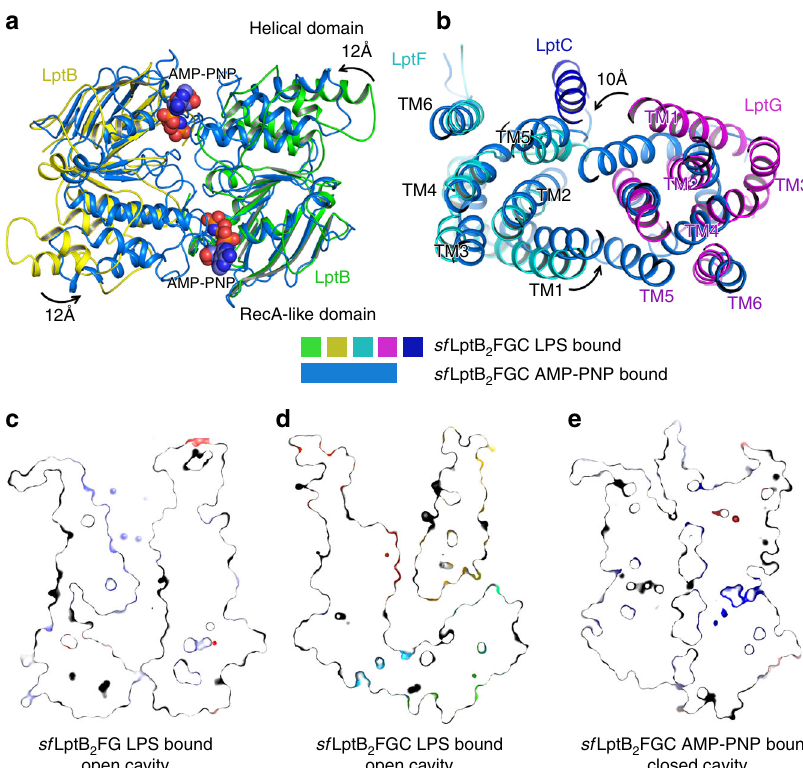
Fig. 5 Superimpositions of AMP-PNP and LPS-bound sf LptB 2 FGC structures. a AMP-PNP binding induces the conformational changes of LptB (NDBs). The helical domains of the dimeric LptB (AMP-PNP-bound sf LptB 2 FGC) showed a rotational shift of ~12 A ̊ in the anti-clockwise direction from the nucleotide- free state of dimeric LptB (LPS-bound sf LptB 2 FGC). The LPS-bound sf LptB 2 FGC is coloured in the same as Fig. 1. The AMP-PNP-bound sf LptB 2 FGC is coloured in marine blue and AMP-PNP shows as spheres. b A top view of superimposed transmembrane helices of LPS-bound sf LptB 2 FGC and AMP-PNP- bound sf LptB 2 FGC complex. AMP-PNP binding induces the TM helices of AMP-PNP-bound sf LptB 2 FGC to rotate in the anti-clockwise direction with the largest shift of ~10 A ̊ from the nucleotide-free state (LPS-bound sf LptB 2 FGC) towards the central channel. c Slab view of surface representation of cavity of LPS-bound sf LptB 2 FG. The cavity is in an outward open conformation. d Slab view of cavity of LPS-bound sf LptB 2 FGC. The cavity is in an outward open conformation. The transmembrane helix of LptC is located at the lateral gate TM1G/TM5F, enlarging the cavity. The neck of the cavity is widely open. e Slab view of cavity of AMP-PNP-bound sf LptB 2 FGC. The cavity is closed, which is induced by AMP-PNP